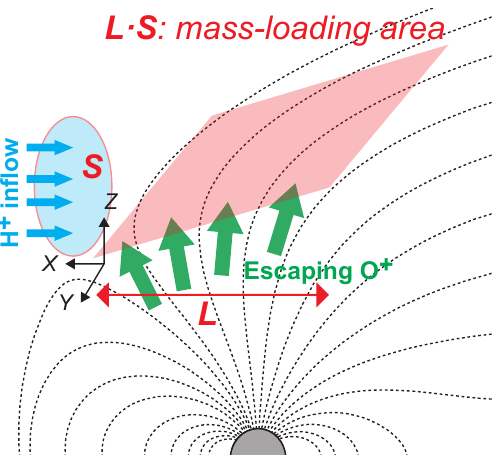
Figure 1. The mass-loading region that we consider (red). Solar wind H + ions (blue arrows) access this region through the blue area (cross section S ), with a width of about 4–10 R E in the Y direction and a thickness of about 5–6 R E in the Z direction (although there is no solid observational statistics for the plasma mantle, these are good estimates, and these numbers disappear from the final formula anyway). The extent of the region in the anti-flow direction ( − X direction) is L